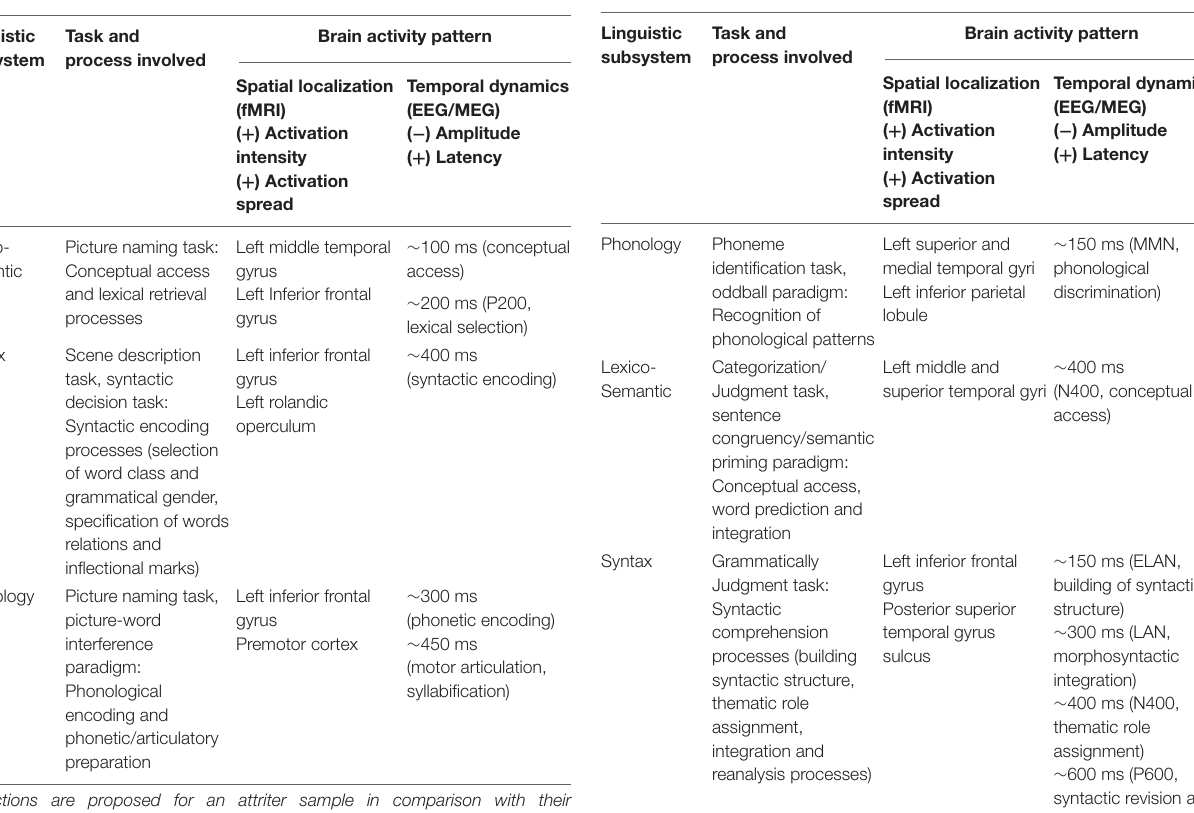
TABLE 2 | Predictions of brain activity patterns during language comprehension obtained by means of functional neuroimaging methods at corresponding anatomic-structure and dynamic-temporal